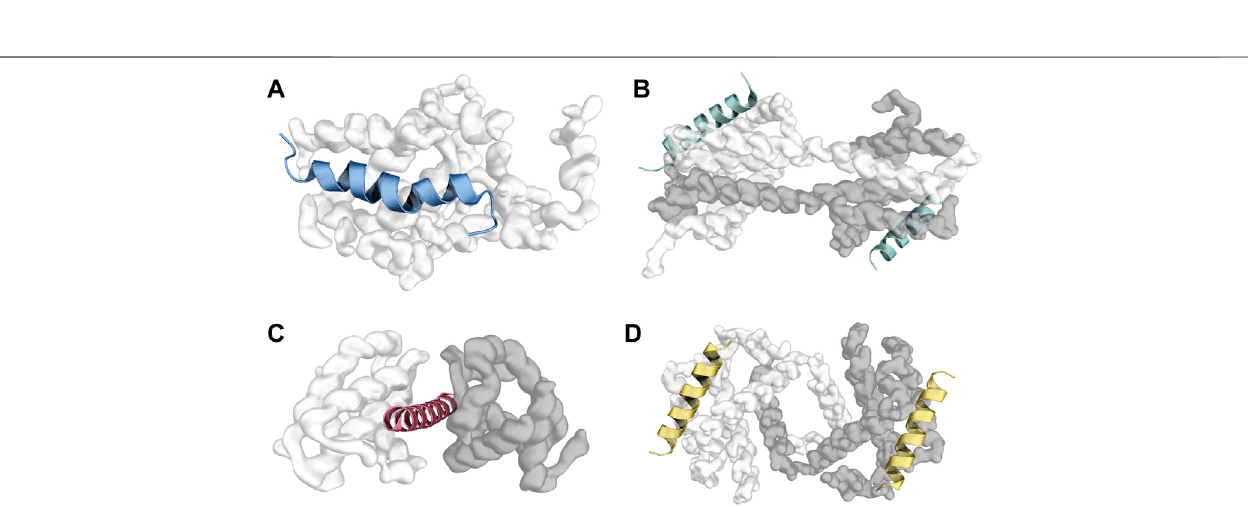
FIGURE 2 | Folded BH3-only proteins and bundling of BH3 motifs of BIM. Panels (A) , (B) , and (D) depict the fold of the BH3-only proteins TPT1 (PDB ID: 2HR9), HEBP2 (PDB ID: 3R8J), and BID (PDB ID: 2BID), respectively. Panel (C) illustrates the tetrameric association between four BH3 peptides of BIM (PDB ID: 6X8O).